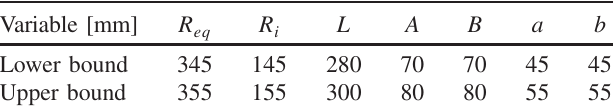
TABLE III. Narrow intervals for the geometric parameters.